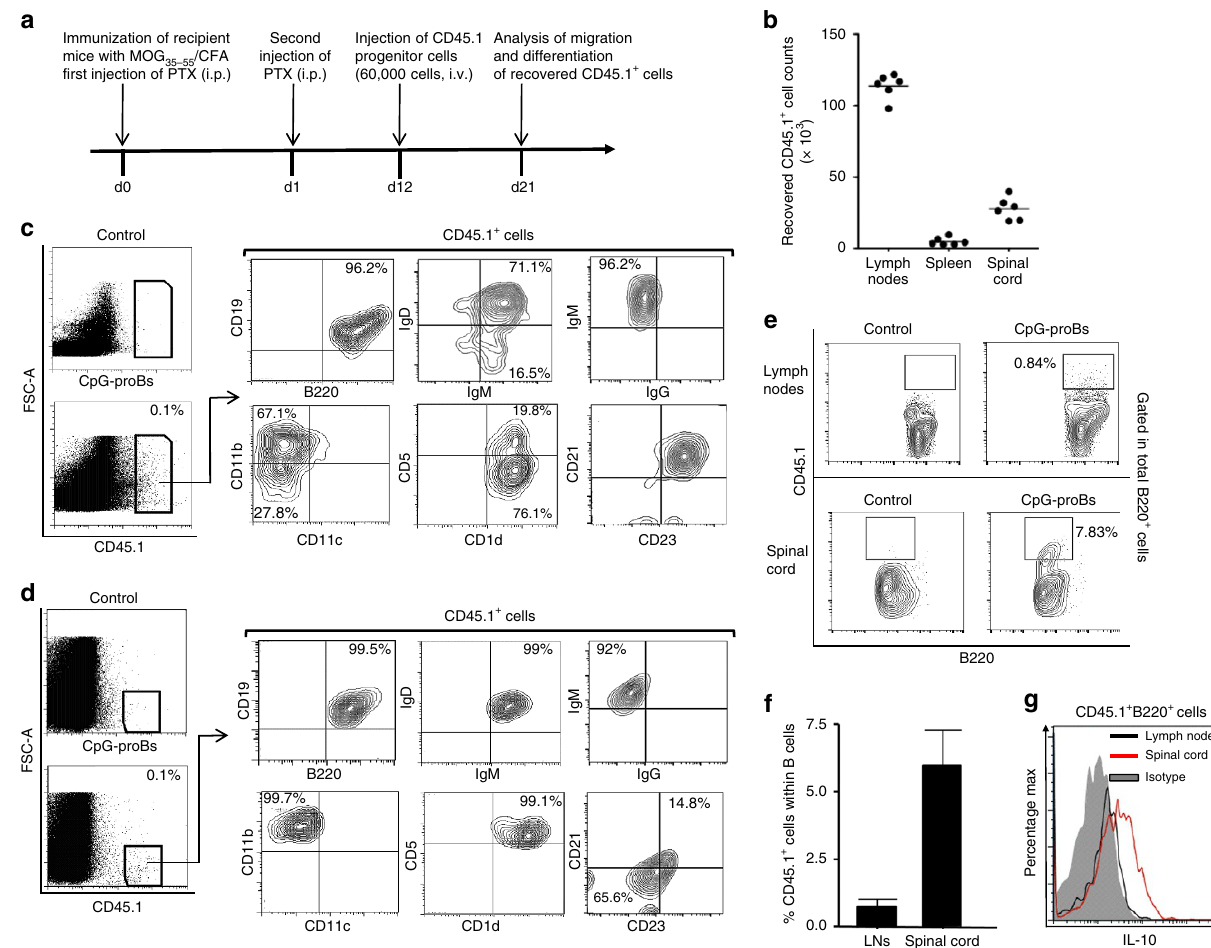
Figure 3 | Phenotypic characterization of CD45.1 þ cells recovered from reactive LNs and spinal cord. ( a ) Experimental protocol: EAE disease was induced in CD45.2 C57BL/6J mice which then were injected at day 12 of the disease with CpG-proB cells, prepared from the BM of congenic CD45.1 þ C57BL/6J and stimulated with CpG-B for 18h. The recovery ( b ) and differentiation status ( c – e ) of CD45.1 þ injected cells were analysed at day 21. ( b ) Absolute CD45.1 þ cell counts recovered within reactive LN, spleen and spinal cord of injected mice at day 21 after immunization, that is, at the peak of the disease, n ¼ 6 mice per group. ( c ) Flow cytometry analysis of the frequency of CD45.1 þ cells recovered in reactive LN at day 21, and of the frequency of gated CD45.1 þ cells expressing the B-cell markers B220, CD19, IgM, IgD, IgG, as well as the markers CD5 and CD1d, CD11b, and CD11c, CD21 and CD23. ( d ) Flow cytometry analysis of the frequency of the CD45.1 þ progeny of CpG-proB cell recipients, recovered within the spinal cord of CpG-proB-injected mice at day 21 of the disease, expressing B220, CD19, IgM, IgD, IgG, CD5, CD1d, and CD11b, CD11c, CD21 and CD23. ( e , f ) Frequency of CD45.1 þ cells derived from injected CpG-proBs gated within total B220 þ cells in a representative experiment ( e ) and as mean ± s.e.m. of three determinations ( f ). ( g ) Frequency of IL-10-producing CD45.1 þ cells in spinal cord and reactive LN, determined by intracellular flow cytometry as shown in the ‘Methods’